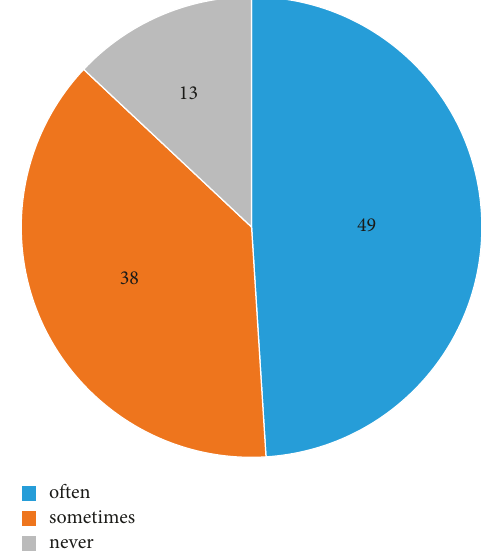
Figure 2: The phenomenon of cultural classes crowding out music classes in rural area.